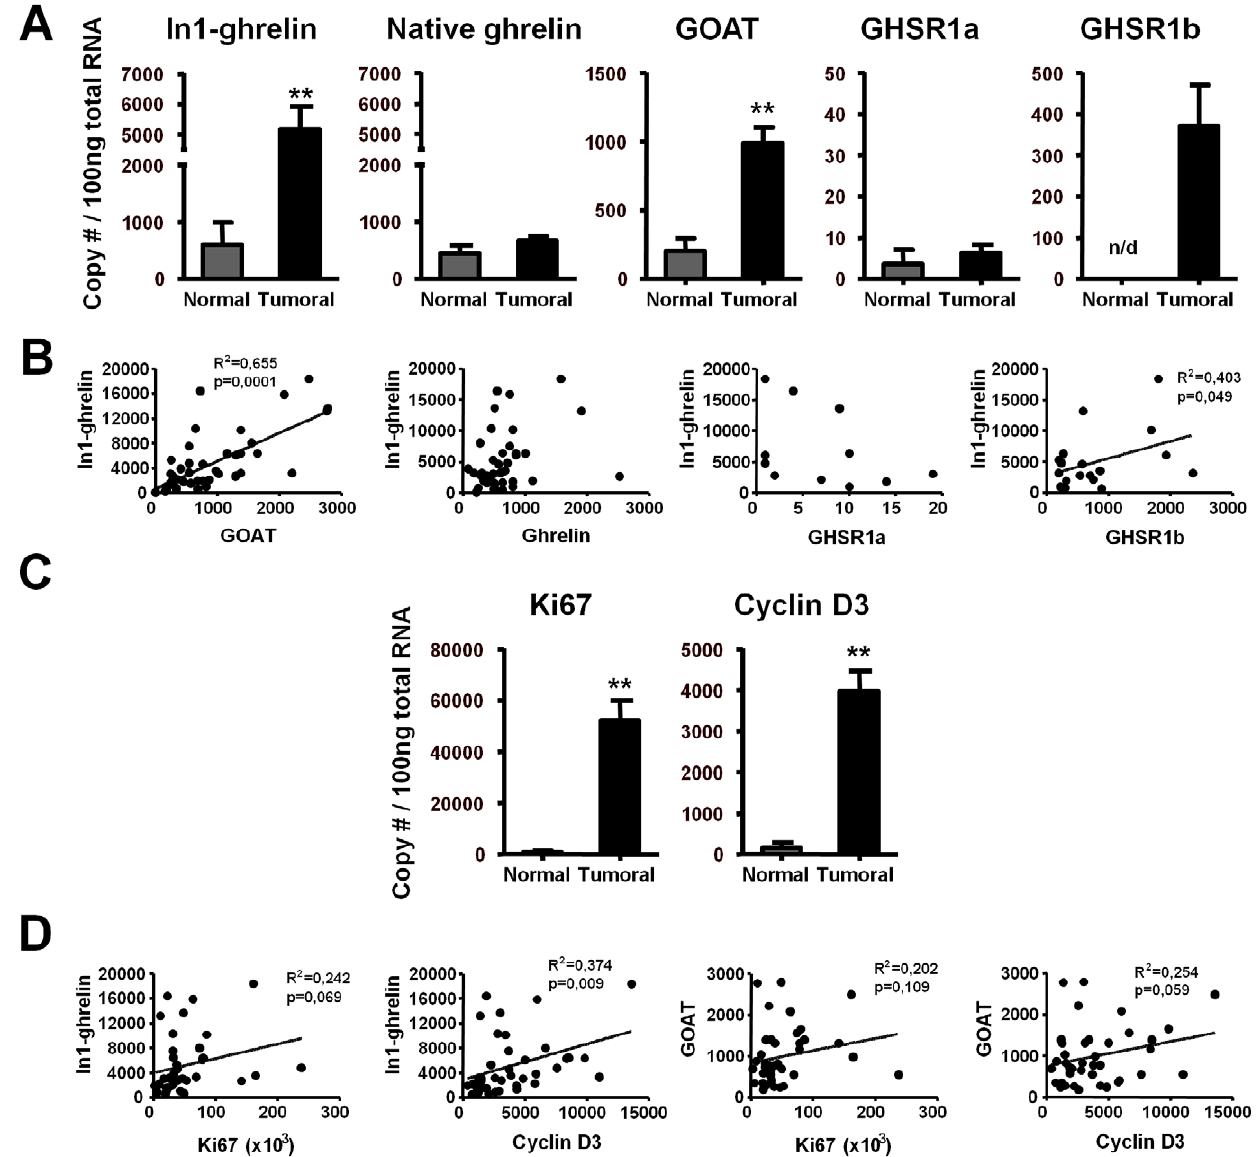
Figure 3. In1-ghrelin variant in human breast samples. (A) Quantitative expression levels of the ghrelin-axis in normal (n=4) and breast cancer samples (n=40). (B) Correlations between In1-ghrelin and ghrelin, GOAT, GHSR1a/1b expression in breast cancer samples. (C) Quantitative expression levels of Ki67 and cyclin-D3 in normal and breast cancer samples. (D) Correlation values between In1-ghrelin and GOAT with Ki67 or cyclin-D3 expression in breast cancer samples. Values are shown as the mean 6 S.E.M (** P , 0.01; indicate differences from controls).